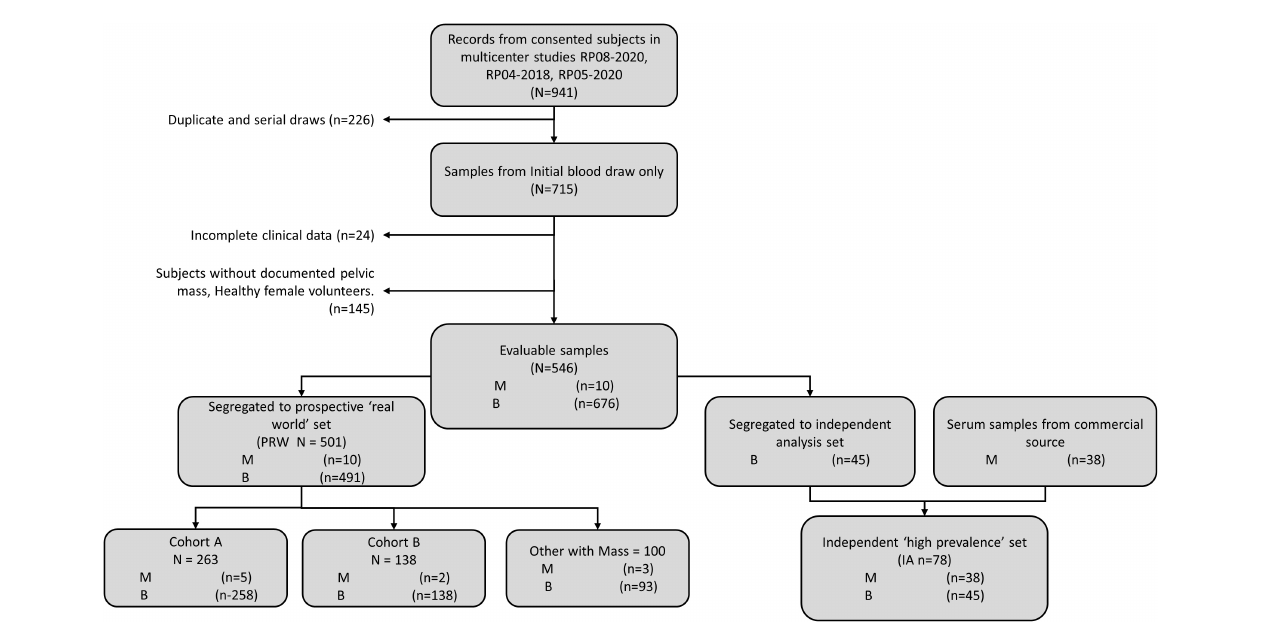
FIGURE5 Work-flow diagram showing stratification of samples from prospective studies into the prospective “real world” (PRW) and independent high-prevalence (IHP) data sets.